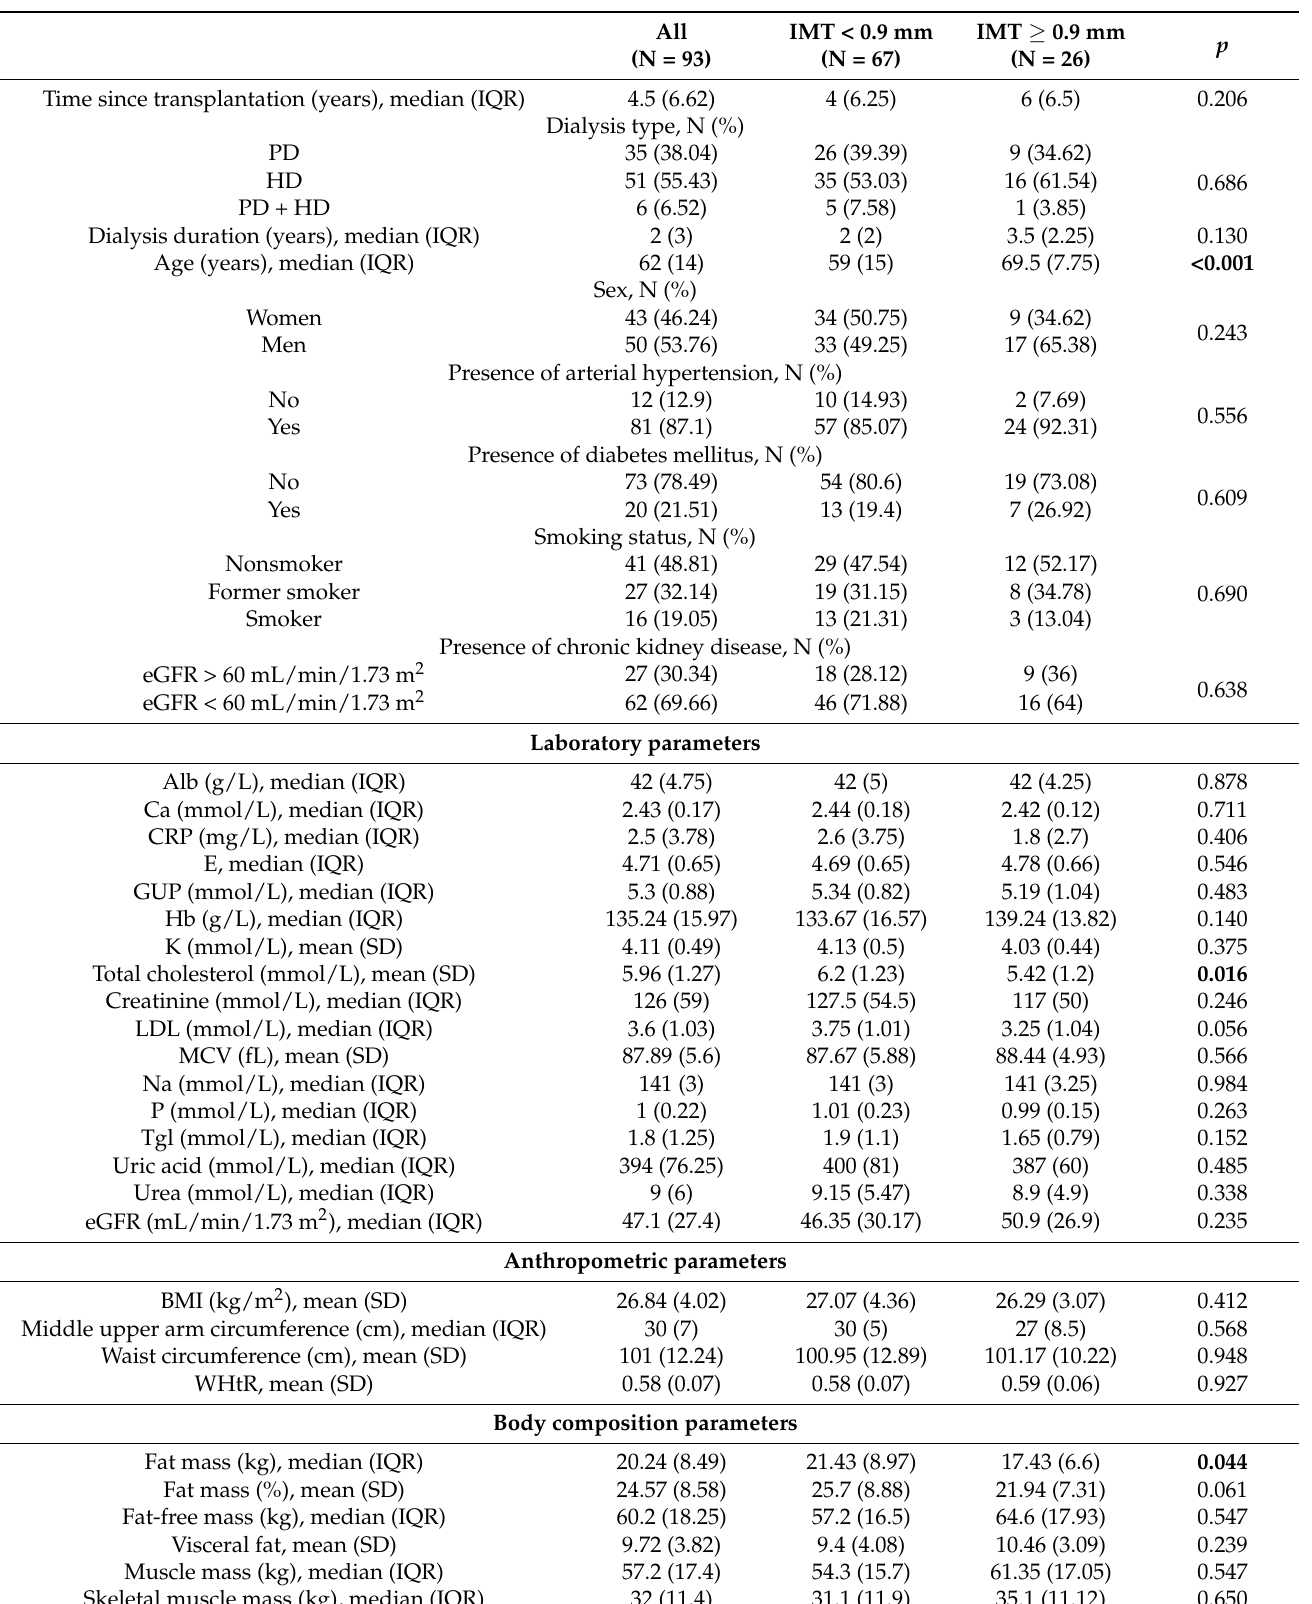
Table 1. Basic characteristics and differences according to intima-media thickness (IMT) in